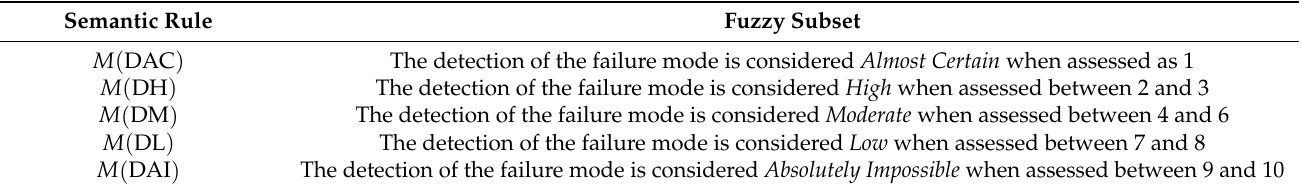
Table 3. Semantic rules for term-set Detection .